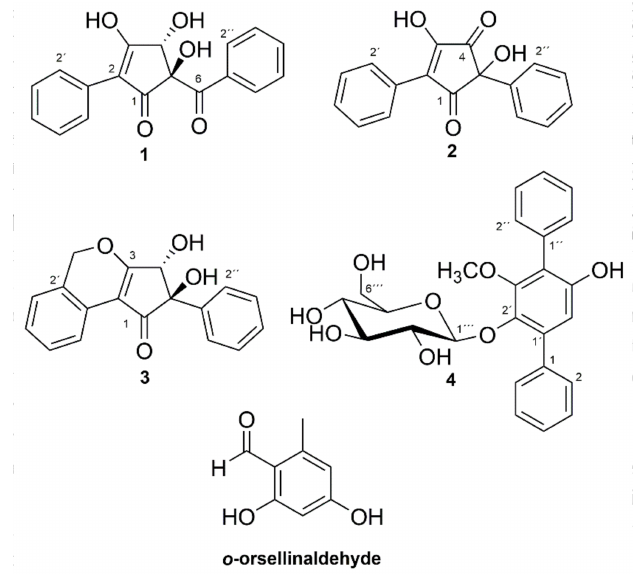
Figure 1. Structures of compounds 1 – 4 and o -orsellinaldehyde. Relative configuration shown for compounds 1 and 3